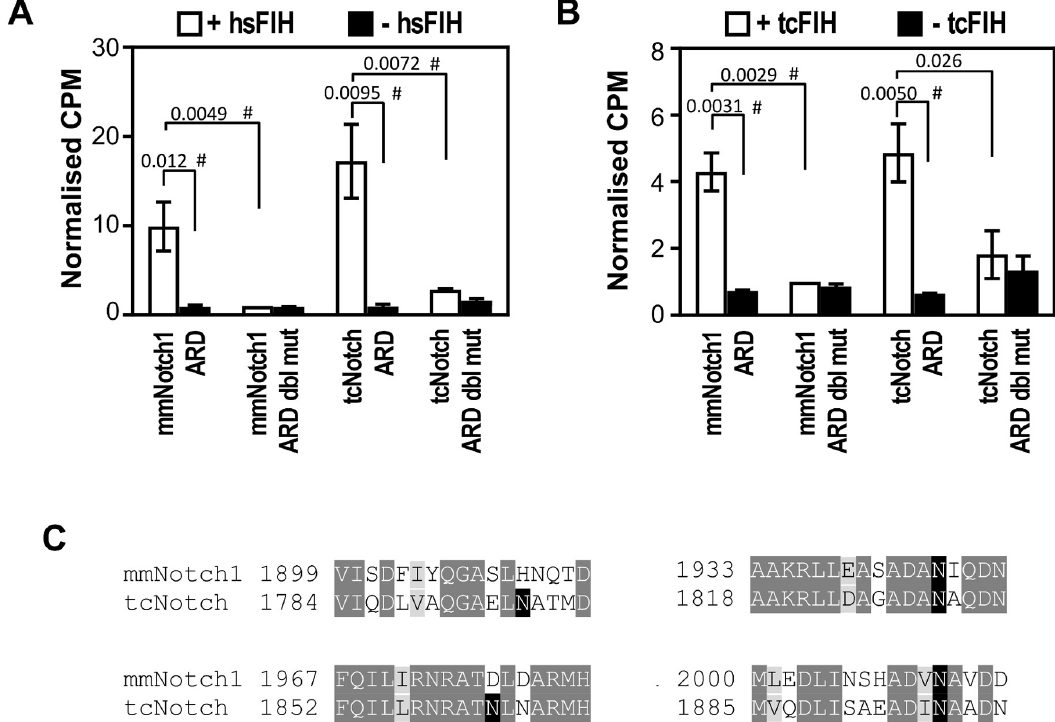
Fig 8. Hydroxylation of ARD-containing substrates by T. castaneum FIH. (A) 1 μ M MBP-tagged tcFIH was tested in triplicate in the presence of 40 μ M Trx-6H-tagged mmNotch1 (1862–2104) (mmNotch1 ARD) or Trx-6H-tcNotch (1747–1989) (tcNotch ARD) and their Asn to Ala mutants mmNotch1 ARD NN1945/2012AA (mmNotch1 ARD dbl mut) and tcNotch ARD NN1830/1897AA (tcNotch ARD dbl mut) by in vitro hydroxylation assay (white bars). As a control, each substrate was also tested in duplicate with buffer in place of enzyme (black bars). Data from each experiment were normalised to CPM (counts per minute of [ 14 C]CO 2 released) for the mmNotch1 ARD dbl mut + FIH sample. Bars are mean +/- SEM of combined data from 3 independent experiments. (B) As for (A), but using hsFIH. (C) Alignment of sequences within tcNotch predicted to contain target Asns with their equivalent regions in mmNotch1. Conserved and similar residues are indicated by dark and light grey highlights, respectively, and the (putative) target Asns are in black. Amino acid numbers are to the left of each sequence. Statistical analysis for parts A and B was carried out on non-normalised, log-transformed data using a 2-tailed paired t-test, with p values indicated above the bars. p values < 0.05 are considered significant. # indicates comparison also significant using the conservative Bonferroni-adjusted significance value of 0.0125 (for parts A and B) for multiple